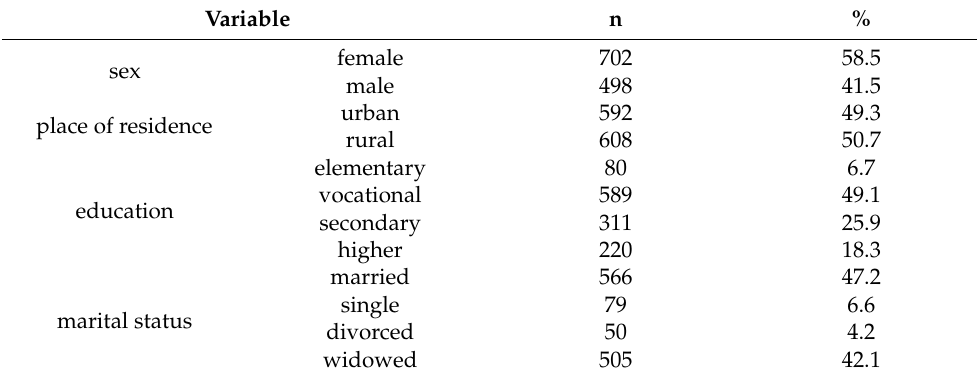
Table 1. Socio-demographic characteristics of patients included in the